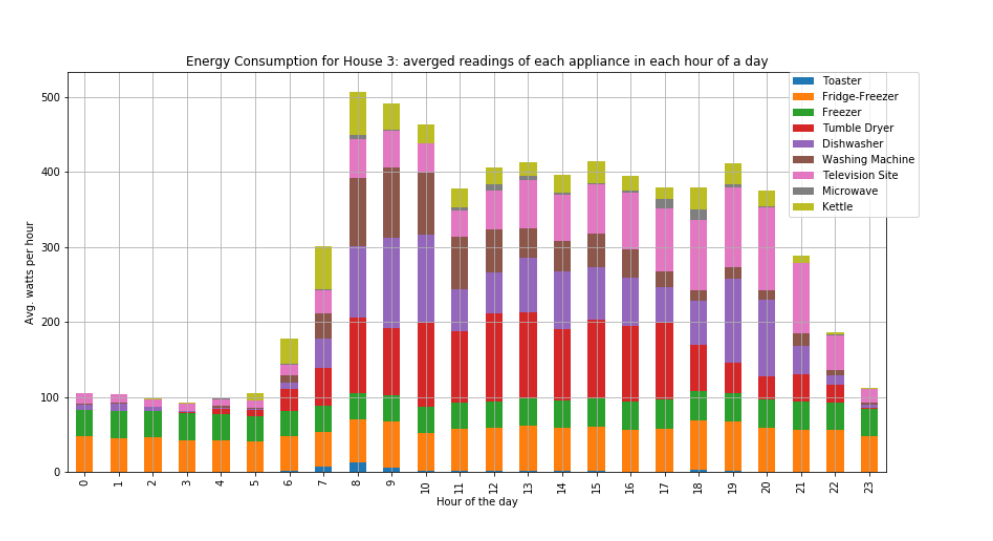
Figure A16. The average consumption per hour of home appliances for house 3 with two